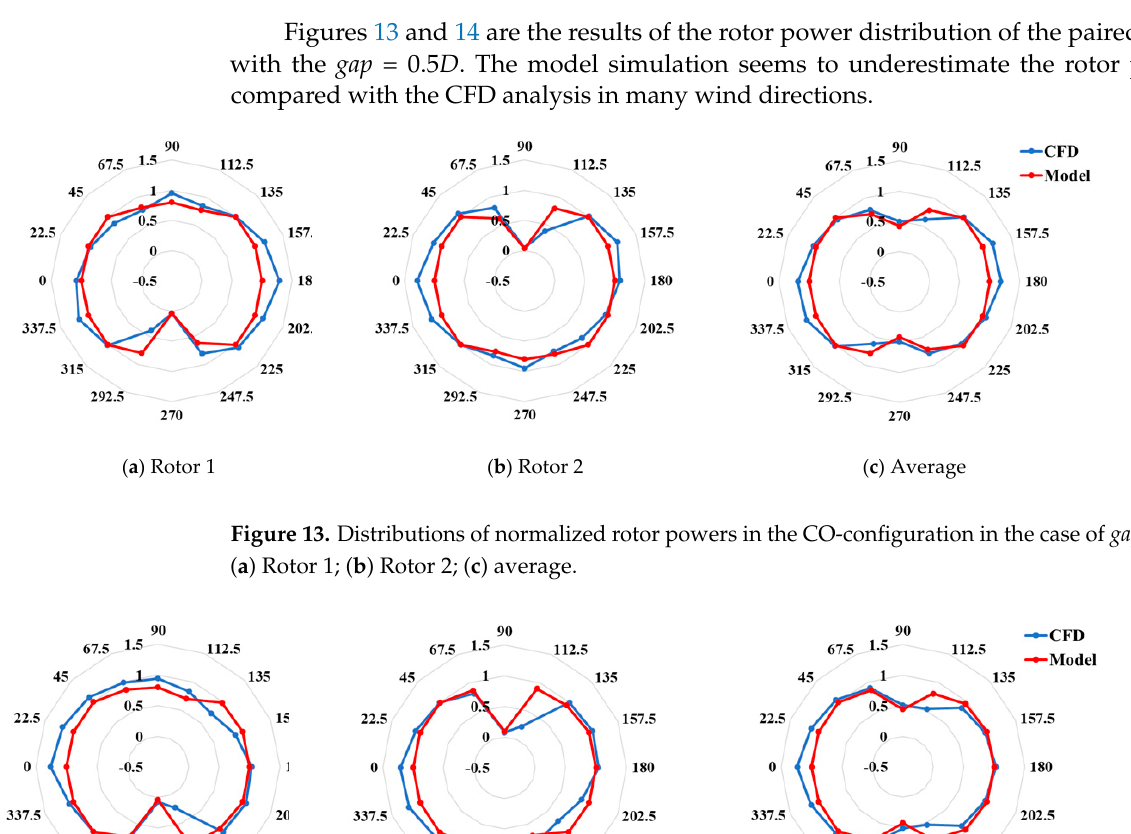
( c ) Average Figure 15. Distributions of normalized rotor powers in the CO-configuration in the case of gap = 2.0 D : ( a ) Rotor 1; ( b ) Rotor 2; ( c ) average. ( a ) Rotor 1 ( b ) Rotor 2 ( c ) Average Figure 16. Distributions of normalized rotor powers in the IR − configuration in the case of gap = 2.0 D : ( a ) Rotor 1; ( b ) Rotor 2; ( c ) average.